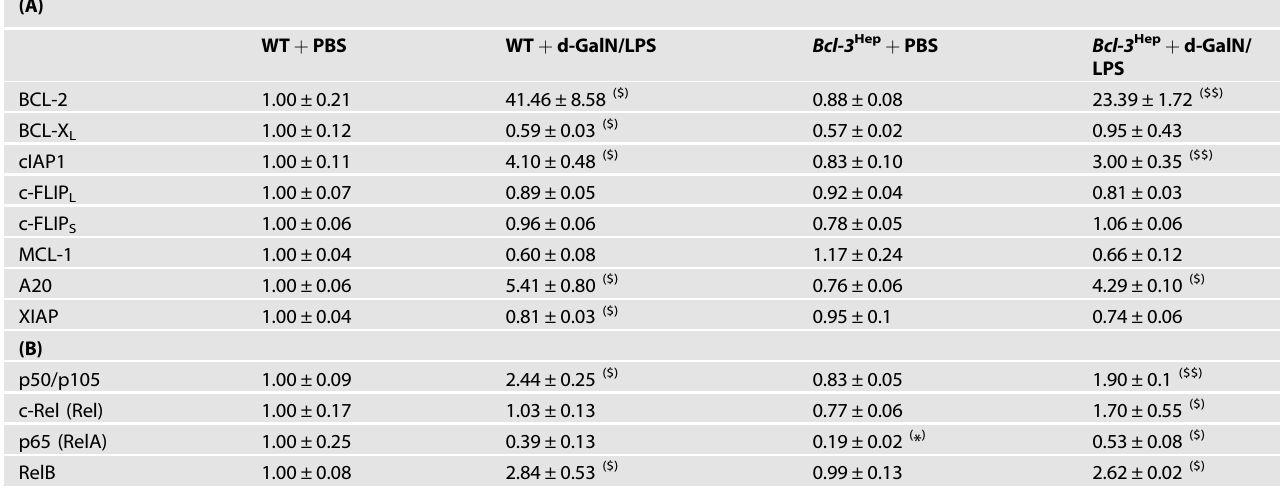
Table 1. Hepatic gene expression of (A) anti-apoptotic proteins and (B) NF- κ B subunits in Bcl-3 Hep and WT mice at 4 h post d-GalN/LPS challenge and in control